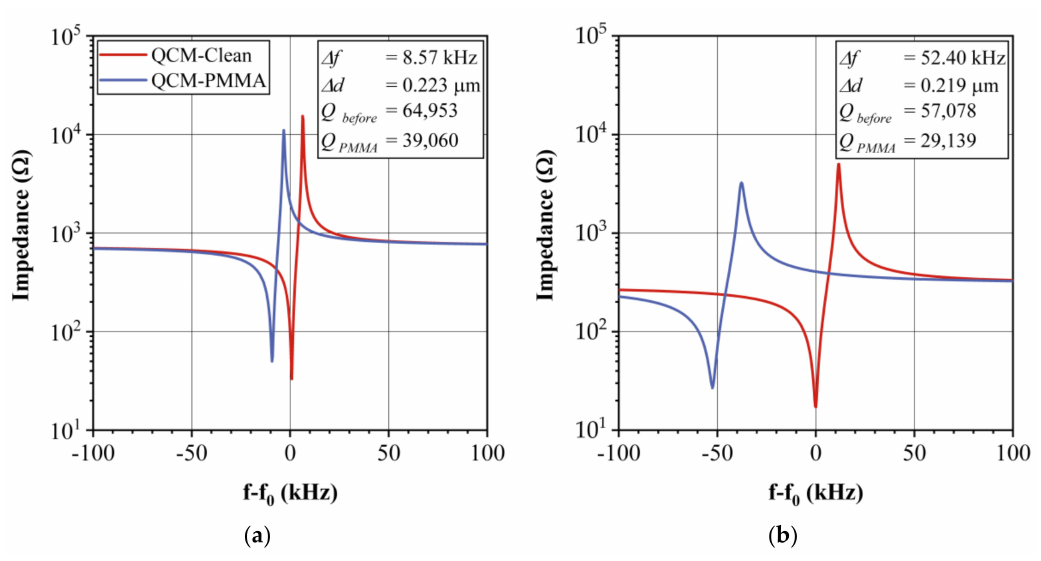
Figure 3. Impedance curves for a QCM without and with PMMA sensing films. ( a ) 12 MHz QCM and ( b ) 30 MHz QCM. Table 1. Variations, before and after coating, of the Q factor and resistance for the QCM